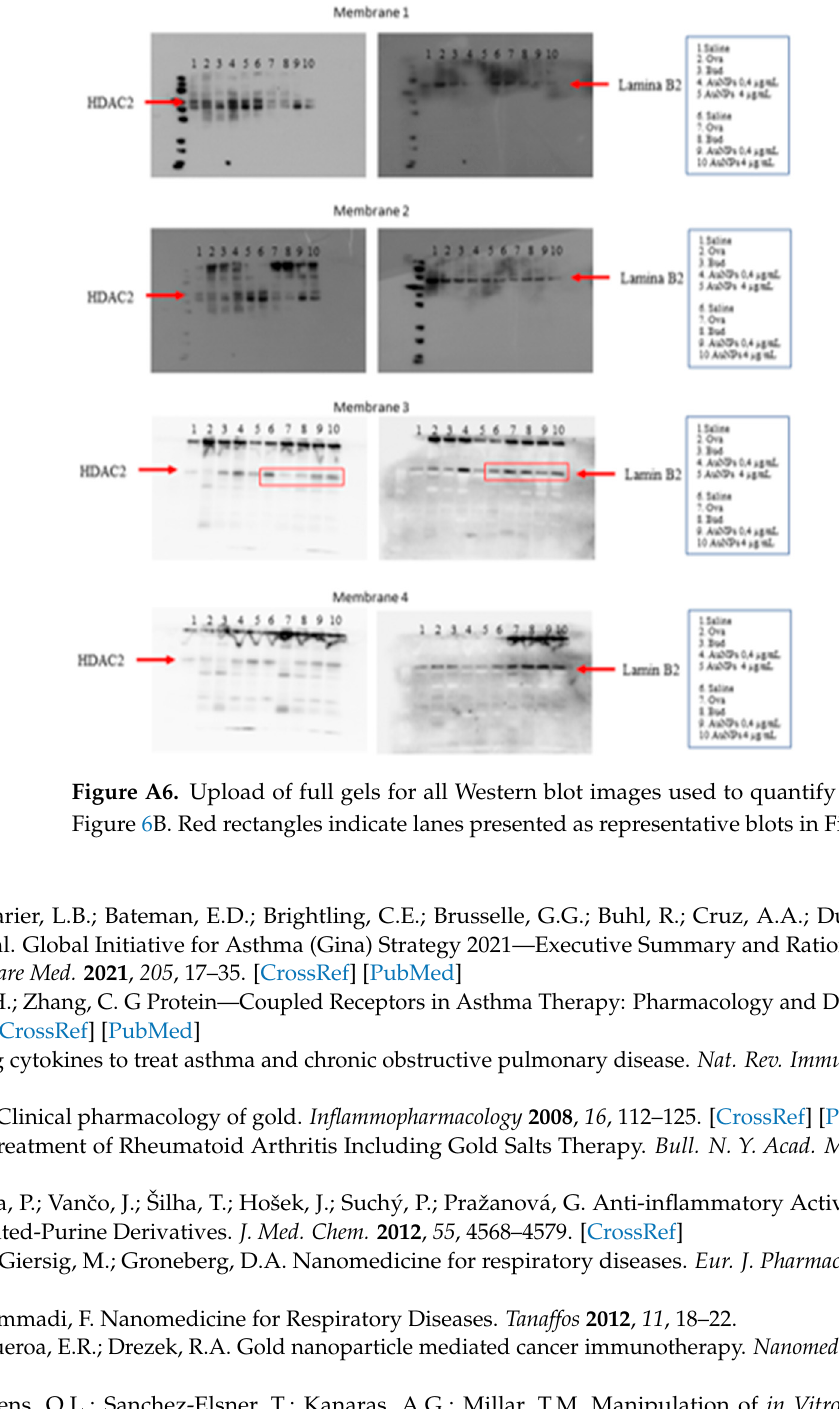
Figure A5. Upload of full gels for all Western blot images used to quantify PI3K δ as shown in Figure 6A. Red rectangles indicate lanes presented as representative blots in Figure 6A.